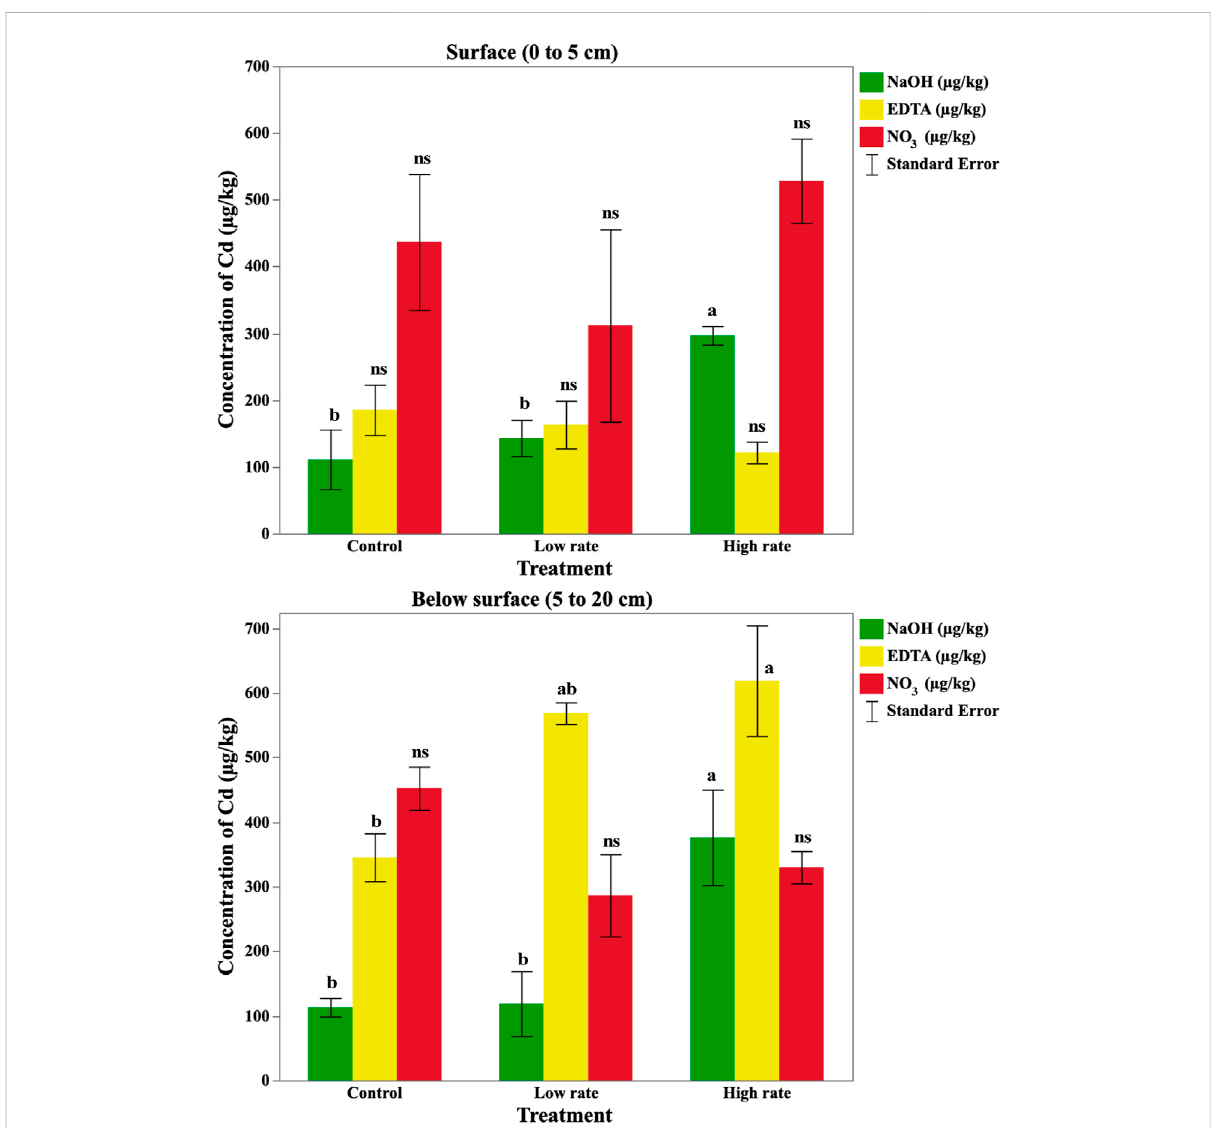
FIGURE 4 Cadmiumconcentrationsinthesoilfractions in fl uencedbythecompostapplied atthesurfaceandbelow-surfacesoildepths offarm4.Letters on the top of the bar indicate the statistical differences between treatments by using Dunnett ’ s post-hoc ( p < 0.05). Ns: no statistical